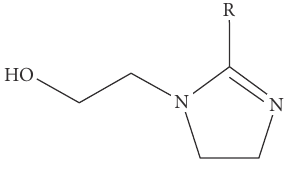
Figure 1: General structure of hydroxyethyl-imidazoline-type inhibitors used, where R is an alkyl chain of 12C for inhibitor A and an oleic chain from coconut oil for inhibitor